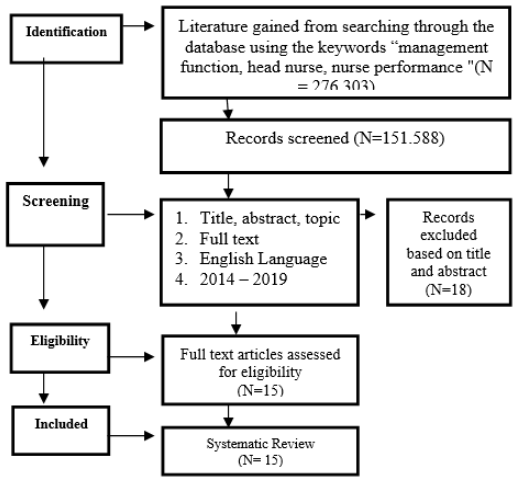
Figure 1. PRISMA flow